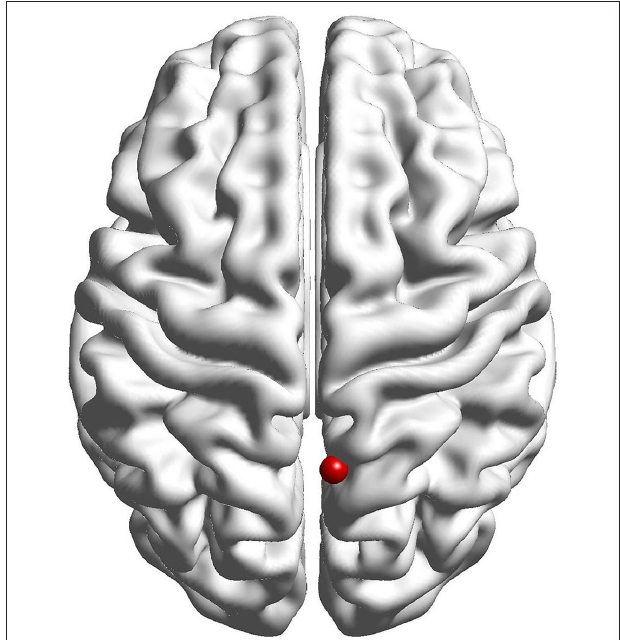
FIGURE 4 | Seed point of the right precuneus for functional connection analysis.